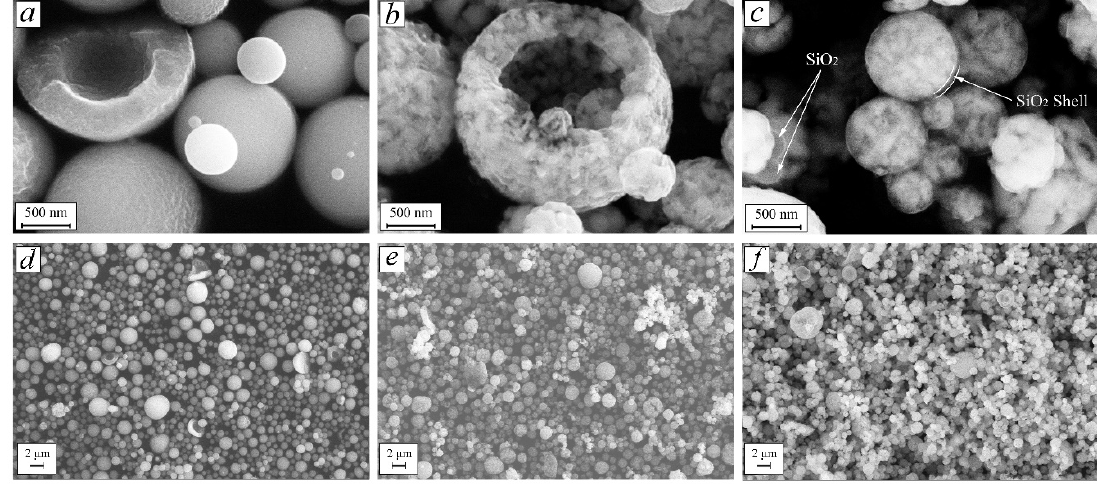
Figure 3. Scanning electron microscopy images: ( a , d ) “Fe 2 O 3 ”, ( b , e ) “Fe”, and ( c , f ) “Fe@SiO 2 ” particles .